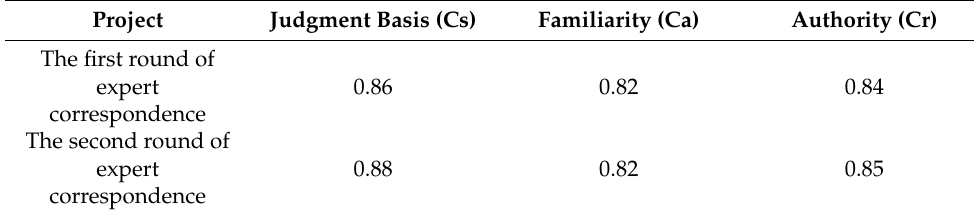
Table 4. Statistical table of authority degree of